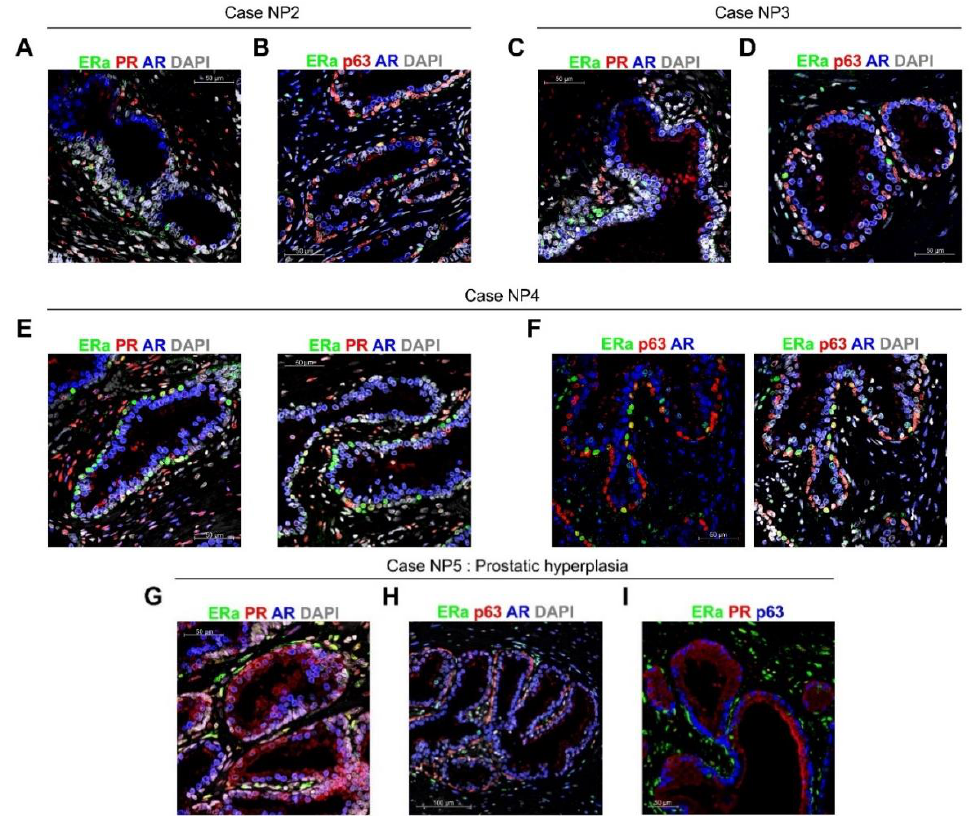
Figure 5. ColNu mIHCF in normal (non-malignant) prostatic tissue from paired cancer cases identifies a basal cell co-expressing p63 and ERa. ( A ) NP2 illustrates the prostate epithelium expressing AR with a few isolated ERa+/AR− epithelial cells. PR is expressed at the stroma together with some ERa positive cells. ( B ) ERa epithelial cells are basal cells co-expressing p63 as seen by the blended yellow color. Few of these cells express greater amounts of ERa than p63, resulting in bright green. The basal layer is p63+, but AR-. The same pattern is repeated in cases NP3 ( C , D ) and NP4 ( E , F ). ( G ) NP5 illustrates a different staining pattern in which the AR+ epithelial cells co-express PR. In addition to the few basal ERa+ cells, a layer of ERa+ elongated cells is also observed. This sample was considered prostate hyperplasia. ( H ) The two types of ERa+ cells are shown at lower magnification. Isolated basal epithelial cells co-expressing p63 and ERa and another layer of elongated ERa in the proximity of the basal layer. ( I ) At high magnification, the prostate epithelium expressing PR, the p63 layer with discrete ERa+ cells, and the second layer of ERa elongated cells p63− can be seen. The order of antibodies in the consecutive cycles is indicated above each photograph. Pseudocolor was kept constant: green for the 1st, red for the 2nd, and blue for the 3rd cycle. DAPI was included in the mounting medium and reveals the nuclei).